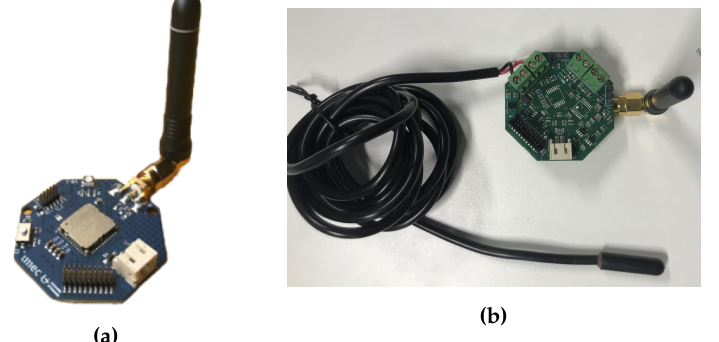
Figure 8. Sensing and radio unit ( a ) Dash7 radio module. ( b ) Sensing unit connected to Dash7 radio